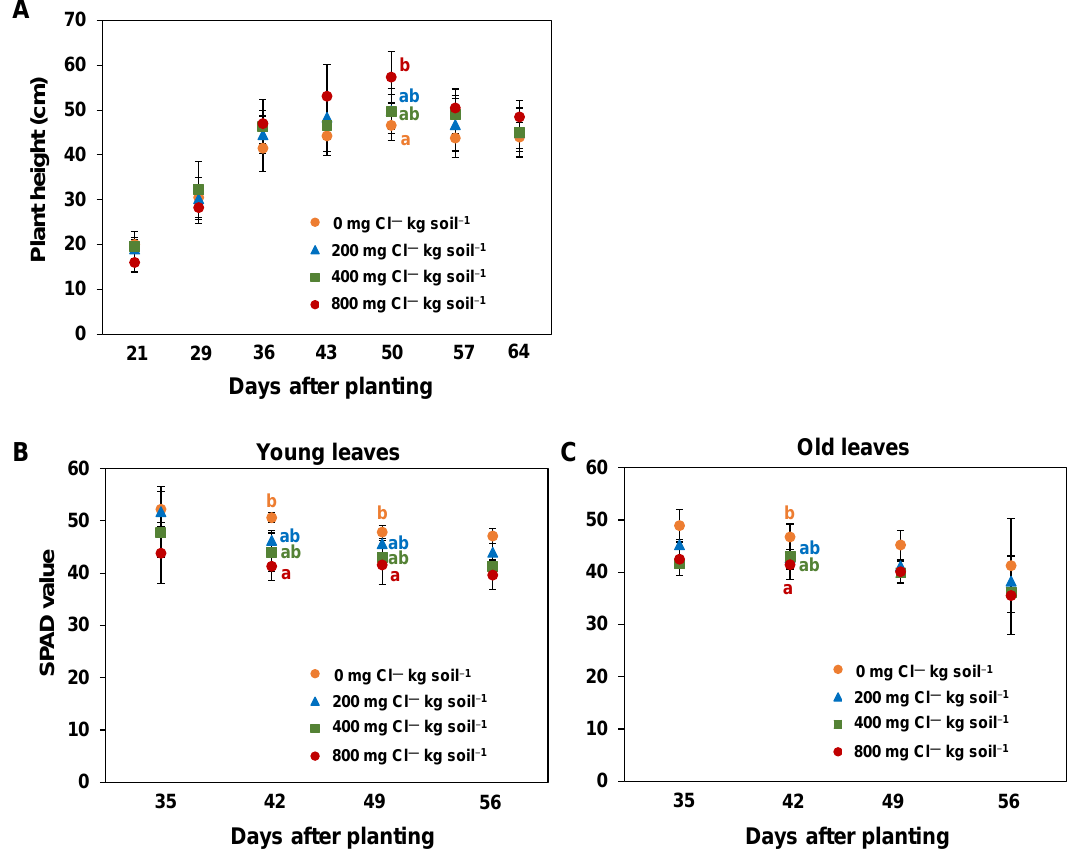
Figure 3. The effect of increasing chloride (Cl — )-fertilization on plant height and relative leaf chlorophyll concentrations. Plant height at seven different times during the growth period from day 21 to day 64 after planting ( A ) and relative chlorophyll concentrations indicated by the dimensionless SPAD value in young ( B ) and old leaves ( C ) at four different times during plant growth from 35 until 56 days after planting. Plants were treated with four Cl — supplies: 0 mg Cl — kg soil − 1 (control plants); 200 mg Cl — kg soil − 1 ; 400 mg Cl — kg soil − 1 ; 800 mg Cl — kg soil − 1 . Mean ± SE values; n = 4. Different lowercase letters indicate significant differences between Cl — treatments at one time point and one plant age (young or old leaves) determined by multiple contrast test. Levels of significance: p < 0.05.